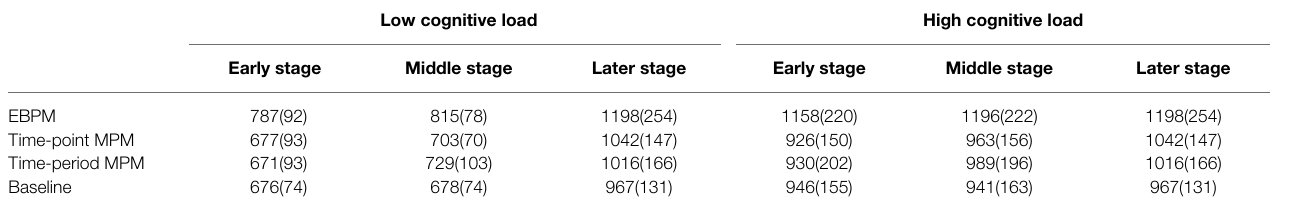
TABLE 4 | The response time of ongoing task in different stages ( M ± SD ).